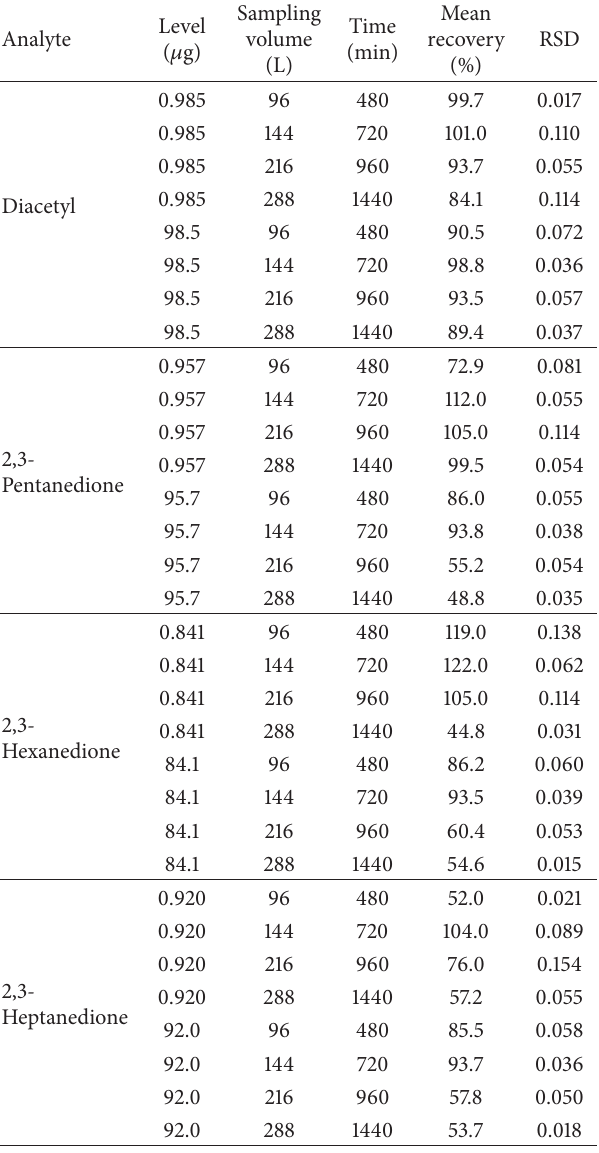
Table 12: Determination of extended air sampling capacity of o - PDA-treated silica gel tubes at 80% relative humidity at 2 concen- tration levels using increased sampling rate (200